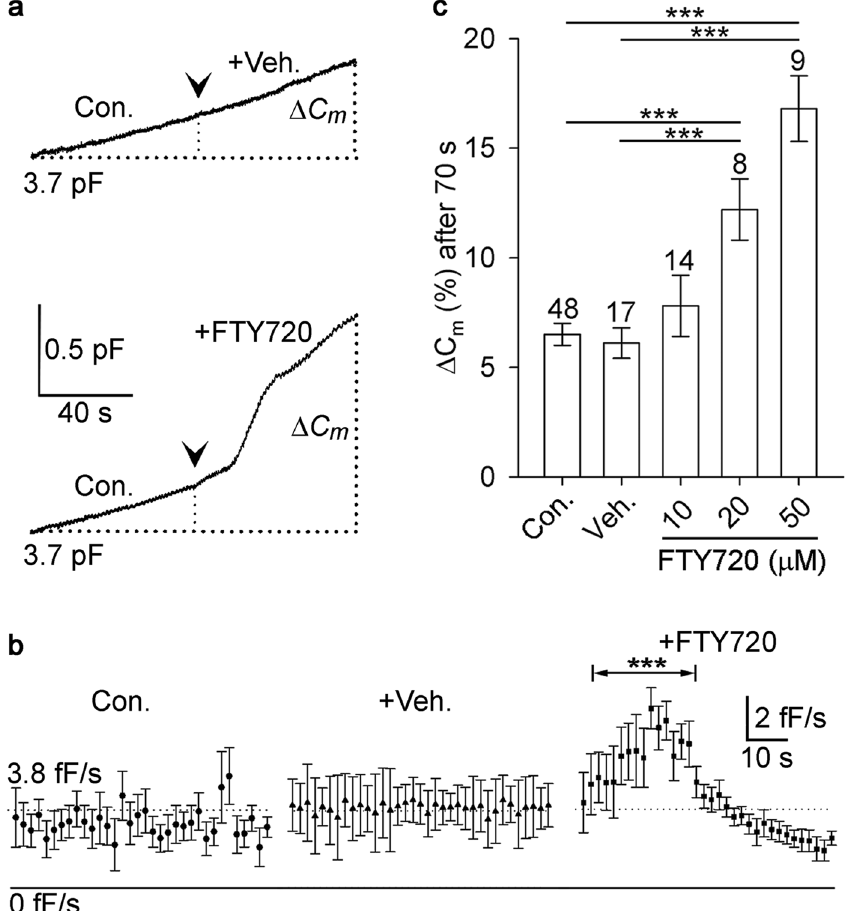
Figure 3. FTY720 enhances stimulated exocytosis in pituitary melanotrophs. ( a ) Representative traces of time-dependent changes in membrane capacitance ( C m ), measured in control conditions (Con.) and after the addition of either vehicle ( + Veh.) or FTY720 (50 μ M). Whole-cell Cm measurements were performed in the presence of 1 μ M calcium in the patch pipette. ( b ) The averaged changes in the derivative of C m ( C m /dt) in control (Con.), vehicle-treated ( + Veh.) and FTY720-treated ( + FTY720) conditions. Note the transient increase of the C m derivative following the addition of FTY720, which indicates enhanced rate of exocytosis ( c ), FTY720 elicited a dose-dependent increase of C m , measured 70 s after the addition of FTY720, at 10 μ M, 20 μ M and 50 μ M concentration ( *** P < 0.001, Mann–Whitney